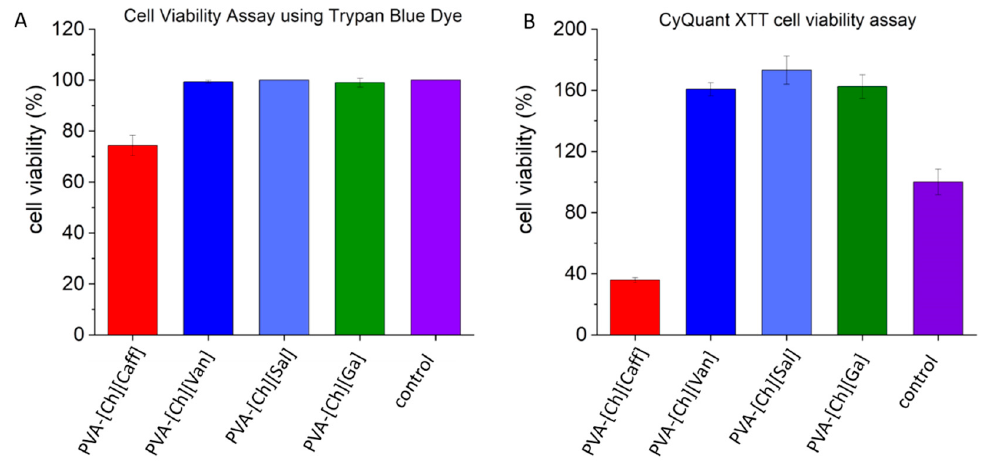
Figure 3. ( A ) Cell viability percentage after 24 h of exposure by trypan blue assay. ( B ) CyQuant XTT Cell viability after 24 h of exposure.